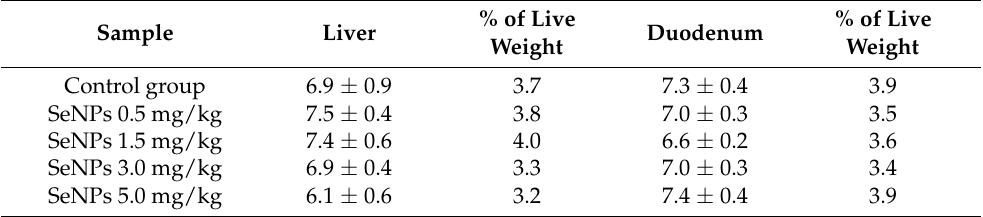
Table 2. Weight (g) of liver and duodenum of Wistar albino rats at the end of the feeding experiment (28